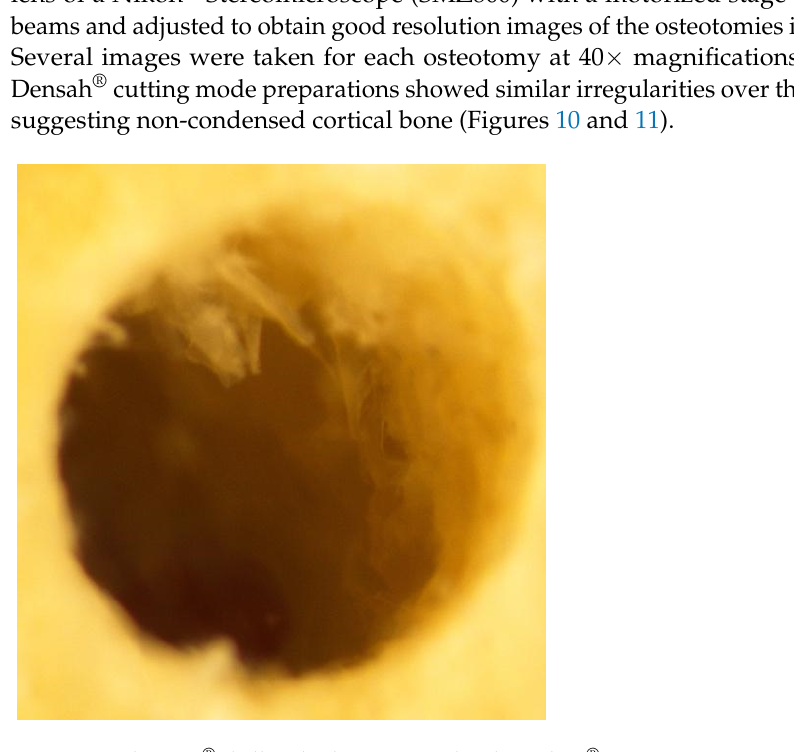
Figure 11. The Densah ® burs’ tibial section under the Nikon ® stereomicroscope, showing similar findings with the MIS ® drills’ tibial section. Irregularities over the osteotomy walls can be seen, sug- gesting non-condensed cortical bone. On the contrary, the osteotomy walls of the Densah ® counterclockwise preparation showed condensed and densified bone, similar to what Versah ® suggests as a finding and as the main purpose of the counterclockwise preparation (Figure 12).